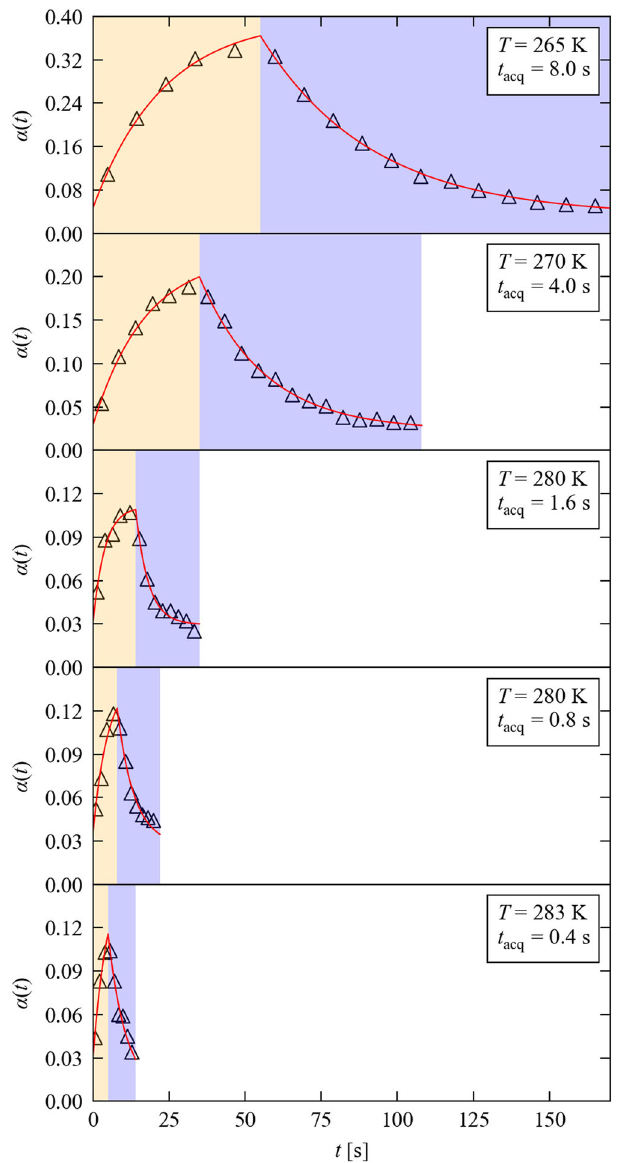
Fig. 2 Time-resolved pump-multiprobe single-crystal diffraction measurements on 1. The fi ve plots show the time dependence of the ES population α ð t Þ during successively shorter pump-multiprobe sequences where the temperature and excitation time are optimised to engineer similar kinetic behaviour. On each plot, the orange and blue shaded regions mark the excitation and decay parts of the sequence, respectively. The markers show the measured α ð t Þ , each re fi ned from a full single-crystal X- ray data set averaged over the time t acq indicated on each plot. The solid lines are fi ts of the data using numerical simulations with a two-process JMAK model with competing excitation and decay.